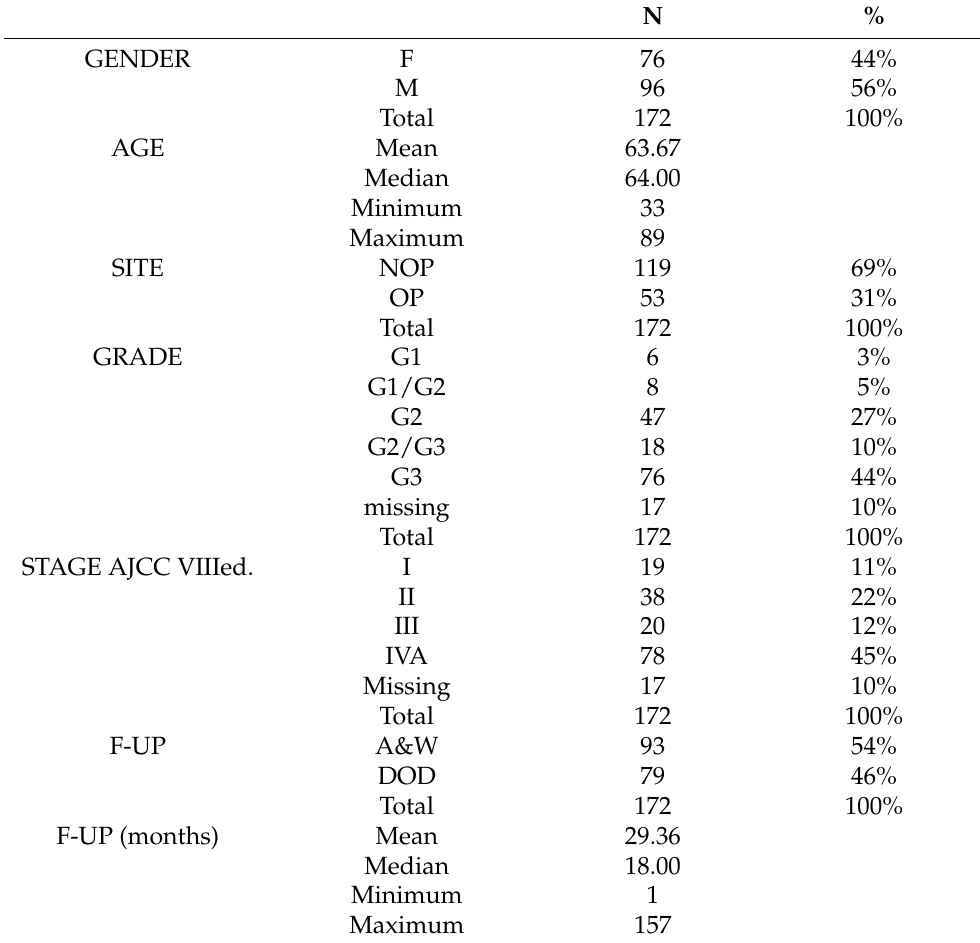
Table 3. Clinico-pathological features of the study population (NOP: Non-Oropharyngeal; OP: Oropharyngeal; A&W: Alive and Well; DOD: Dead of Disease).